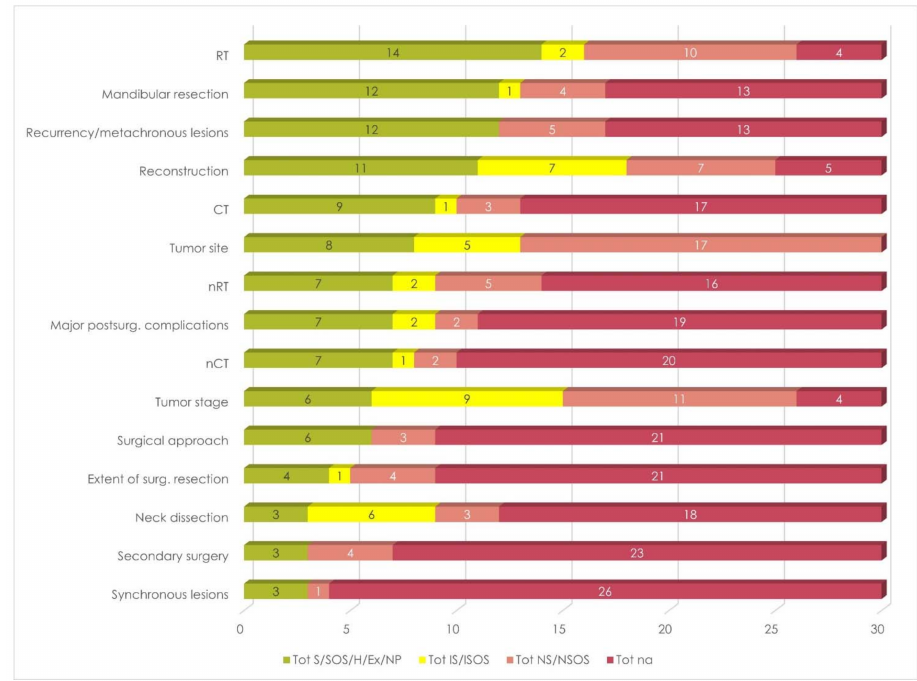
Figure 3. Overall stratification by DT variables. Legend to Figure 3: CT = adjuvant/definitive chemotherapy; Ex = excluded; H = homogeneous; IS = incomplete/inadequate stratification; ISOS = incomplete/inadequate stratification by oral subsites; na = not available; nCT = neoadju- vant chemotherapy; ND = neck dissection; NP = not present; nRT = neoadjuvant radiotherapy; NS = not stratified; NSOS = not stratified by oral subsites; RT = adjuvant/definitive radiotherapy; S = stratified; SOS = stratified by oral